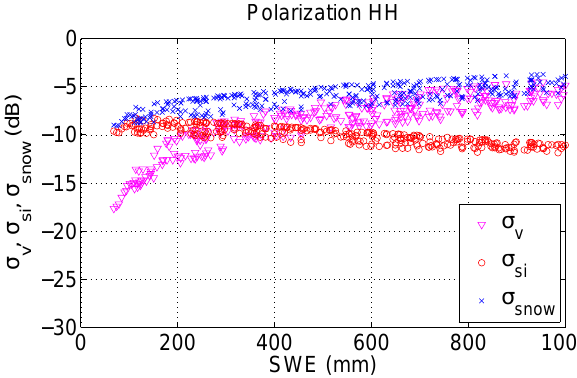
Figure 3. Test of EBM simulations on X-band, HH polarization for varying snow depth and optical diameter: snow density 250kgm − 3 , optical diameter 0.2–1mm, and snow depth 30–400cm. The glacier roughness is fixed at σ si = 0.9cm and l si = 8.6cm.